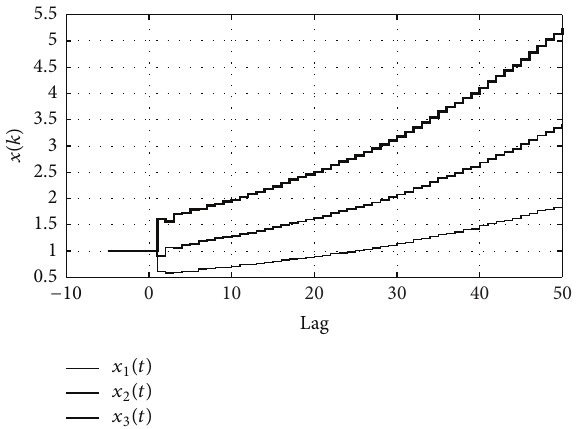
Figure 1: The initial state responses of system (56).